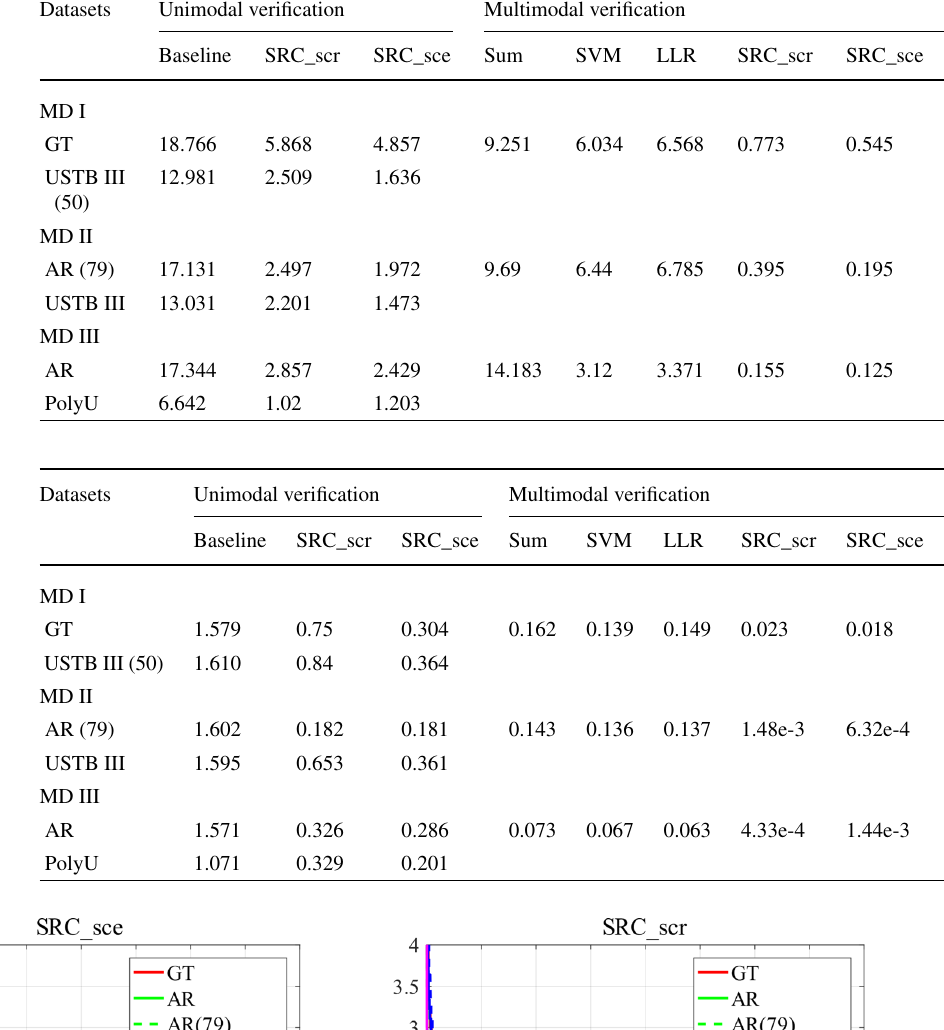
Table 3 Biometric verification performance (EER, %) when using DCT features